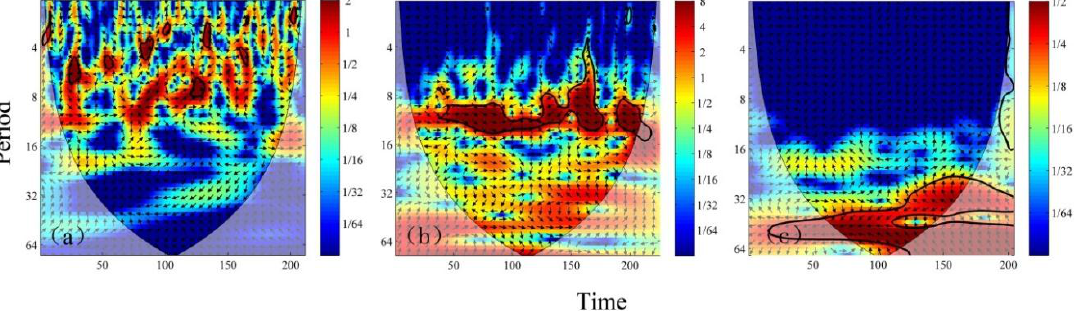
Figure 10. Cross-wavelet transform of the reconstructed PDSI p6-7 of the northern Daxing’anling Mountains region with ( a ) El Niño-Southern Oscillation (ENSO) index; ( b ) sunspot number (www.sidc.be/silso/datafiles); and ( c ) North Atlantic Oscillation (NAO) index. The 5% significance level against red noise is shown as a thick contour. The relative phase relationship is shown as arrows (with in-phase pointing right, anti-phase pointing left).